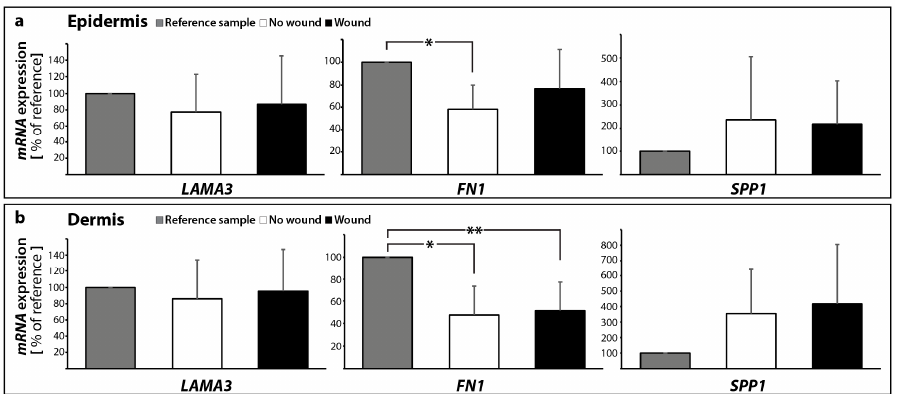
Figure 10. Gene expression patterns of selected extracellular matrix proteins: altered mRNA expression levels are shown for reference control (0 day), unwounded and wounded skin samples after ten days in organ culture medium. LAMA3 , FN1 and SPP1 mRNAs were investigated for epidermis ( a ) and dermis ( b ) samples respectively; * p < 0.05 reference vs. no wound, ** p < 0.05 reference vs. wound. Table 1. Fold changes in gene